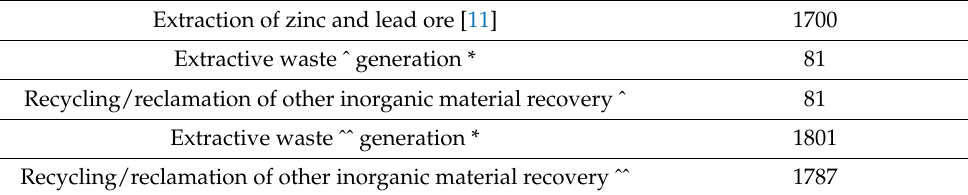
Table 2. ZGH “Bolesław” S.A.—extraction of zinc and lead ore and reported waste, ths. tons, 2017. Extraction of zinc and lead ore [11] 1700 Extractive waste ˆ generation * 81 Recycling/reclamation of other inorganic material recovery ˆ 81 Extractive waste ˆˆ generation * 1801 Recycling/reclamation of other inorganic material recovery ˆˆ 1787